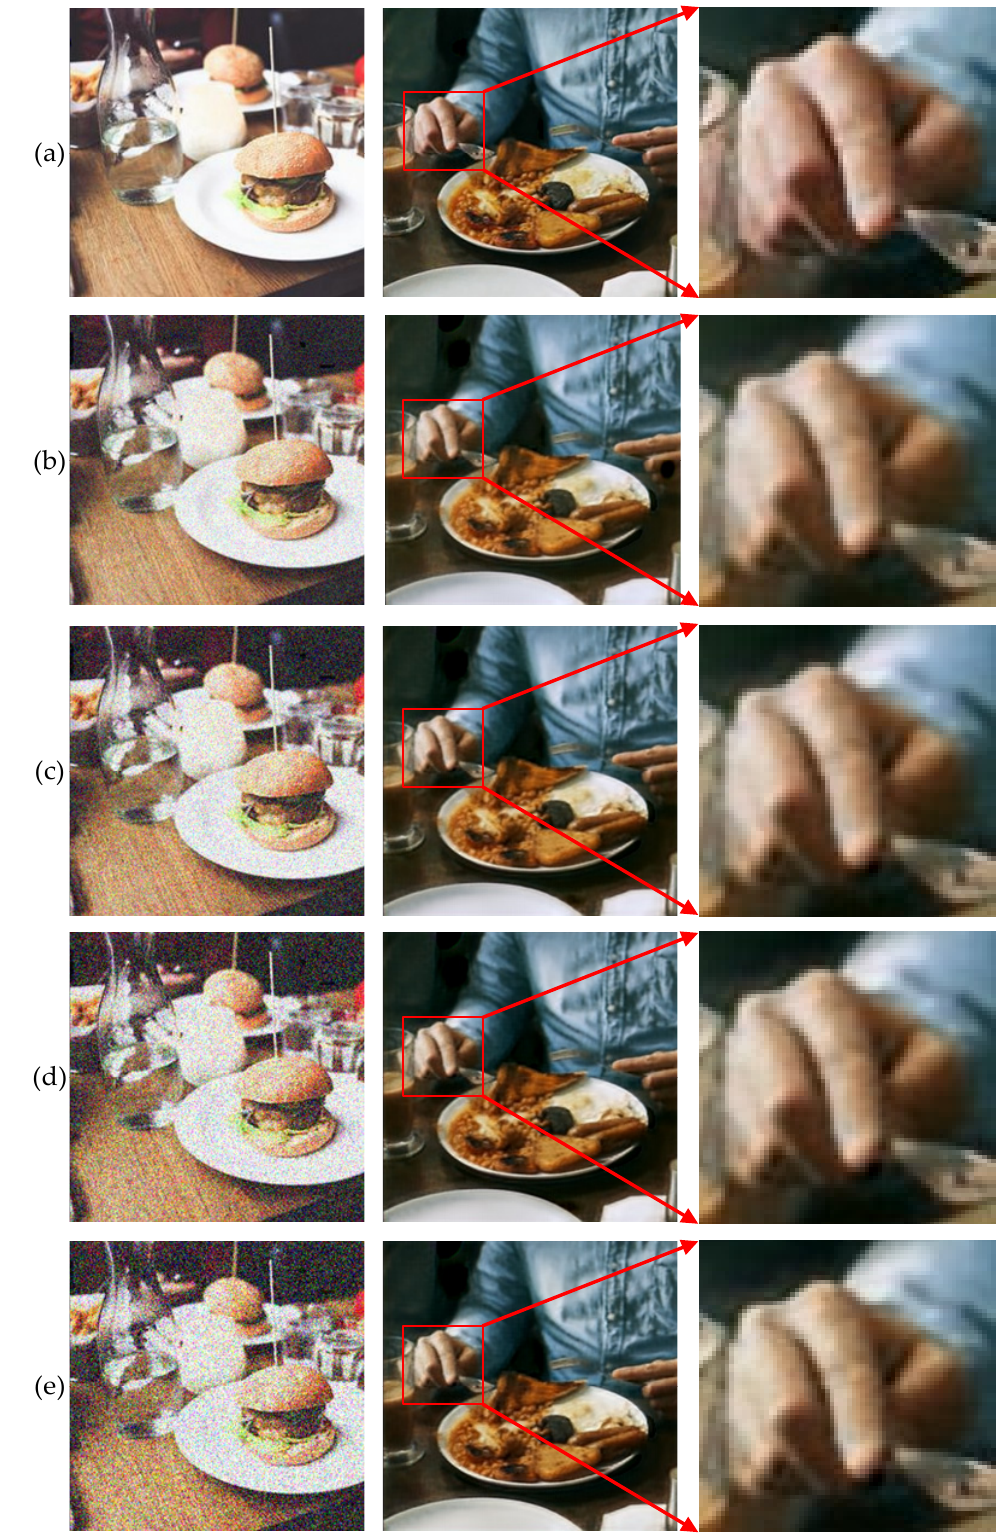
Figure 10. Recovery results of secret images with different intensities of Gaussian noise added to container images: ( a ) 0, ( b ) 0.01, ( c ) 0.04, ( d ) 0.08 and ( e ) 0.12 dBW. From left to right correspond to containers, reconstructed secret images and magnified hand areas in the reconstructed images, respectively.